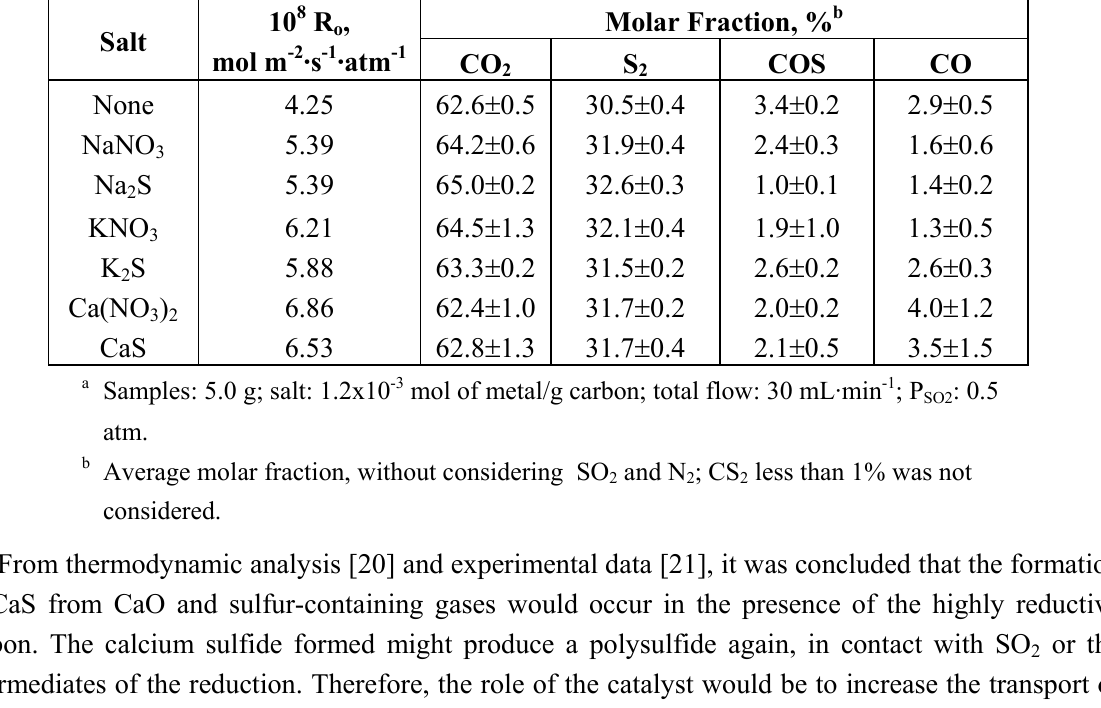
region of activated carbon after the reaction with SO 2p . Sample: 2.0 g; salt 1.2x10 -3 mol of metal; total 2 0.2 atm; a) no salt added; b) in the presence of NaNO SO2 2